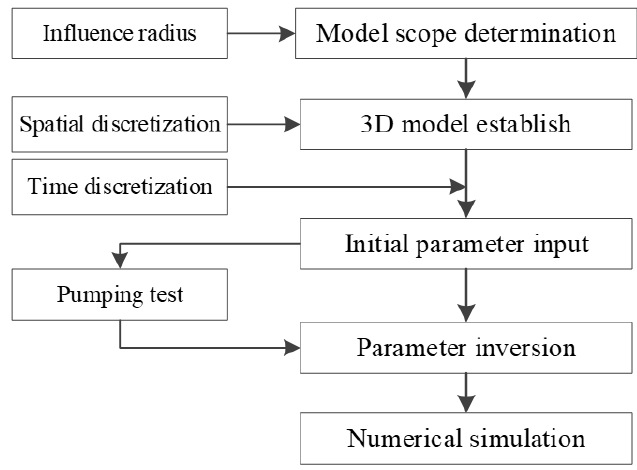
Figure 4. Flow chart of the building numerical model.